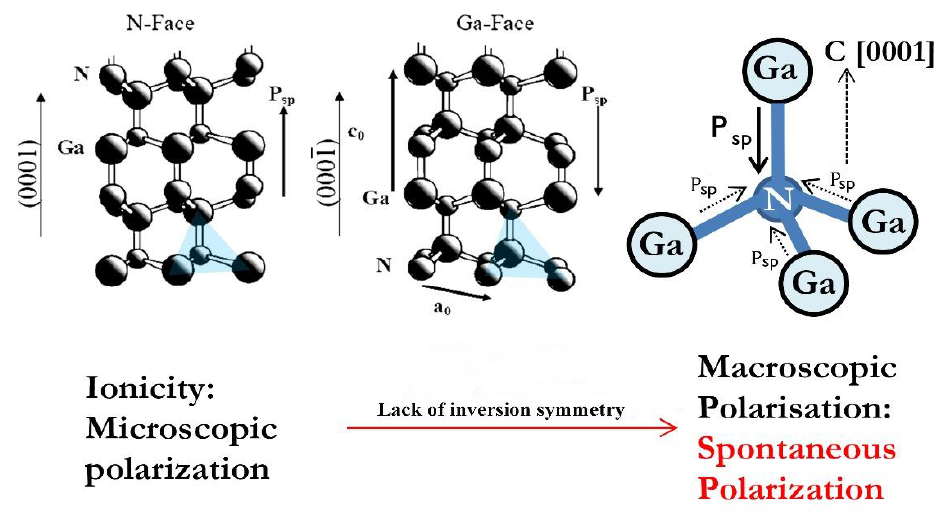
Figure 10. The alignment of P SP and the tetrahedral bond structure of Ga-face and N-face heterostructures. Reproduced with permission [20]. Copyright 2019, Elsevier .